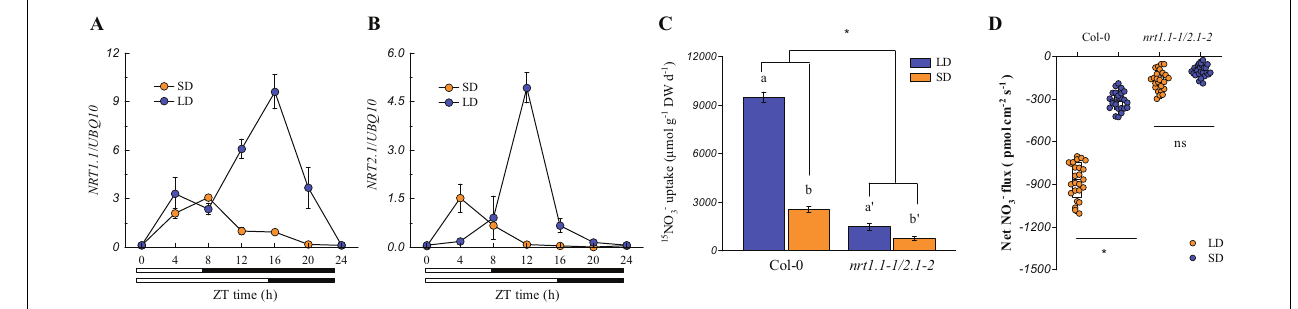
FIGURE 4 | LD photoperiods upregulate NRT1.1/NRT2.1 - mediated nitrate uptake in the roots. The expression pattern of NRT1.1 (A) and NRT2.1 (B) in the roots of Col-0 plants grown under LD (16-h light/8-h dark) and SD (8-h light/16-h dark) photoperiods. Seedlings (at the stage when four leaves were visible) grown in agar medium with 1 mM KNO 3 were harvested. Bars below the graph indicate the duration of day (white) and night (black). Expression levels are normalized to the expression level of UBIQUITIN 10 . (C) Nitrate uptake rate in the roots of the Col-0 plants and nrt1.1-1/2.1-2 mutants under both LD and SD conditions. The plants were grown hydroponically for 2 weeks with 3 mM KNO 3 to ensure that the nrt1.1-1/2.1-2 plants would not show severe signs of N limitations. The plants were then grown in 1 mM nitrate for another week, after which the daily nitrate uptake rate by the roots was evaluated using 1 mM 15 NO 3 - . (D) Supplementary Figure 14 Net NO 3 - flux in the roots of Col-0 plants and nrt1.1-1/2.1-2 mutants grown in agar systems under SD and LD conditions. Nitrate (1 mM) was used as the exclusive N-source in this section. Seedlings (at the stage when four leaves were visible) grown in agar medium were used to measure the net nitrate fluxes in the maturation zones at ZT 1-2 h. Data represent the means ± standard deviations ( n = 4). Different letters indicate significant differences between the means as determined by using a two-way ANOVA followed by Tukey’s multiple comparisons test ( P < 0.05). Significant interactions between the photoperiod and genotype are indicated by an asterisk (* P < 0.05; ns,